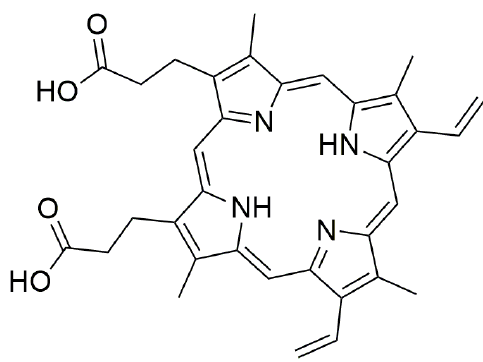
Figure 12. Chemical structure of protoporphyrin IX (PPIX).